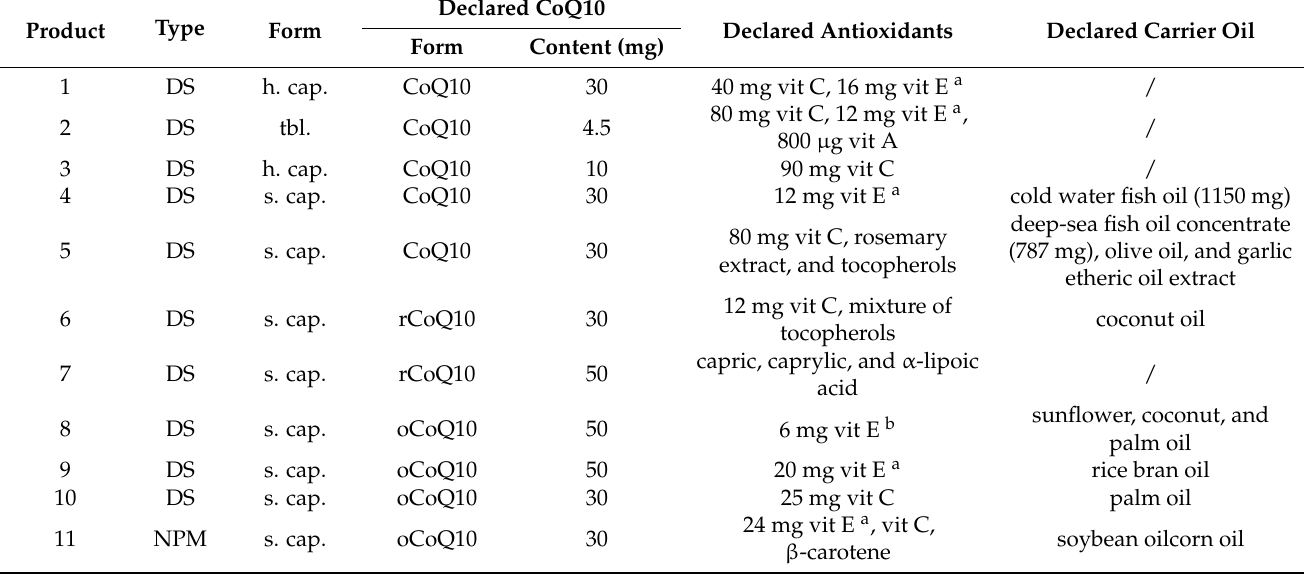
Table 1. Data on the tested